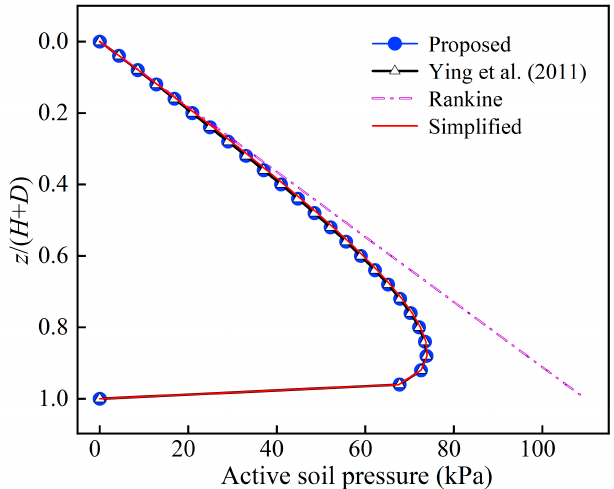
Figure 8. Distribution of finite soil pressure compared with those of previous studies [18].